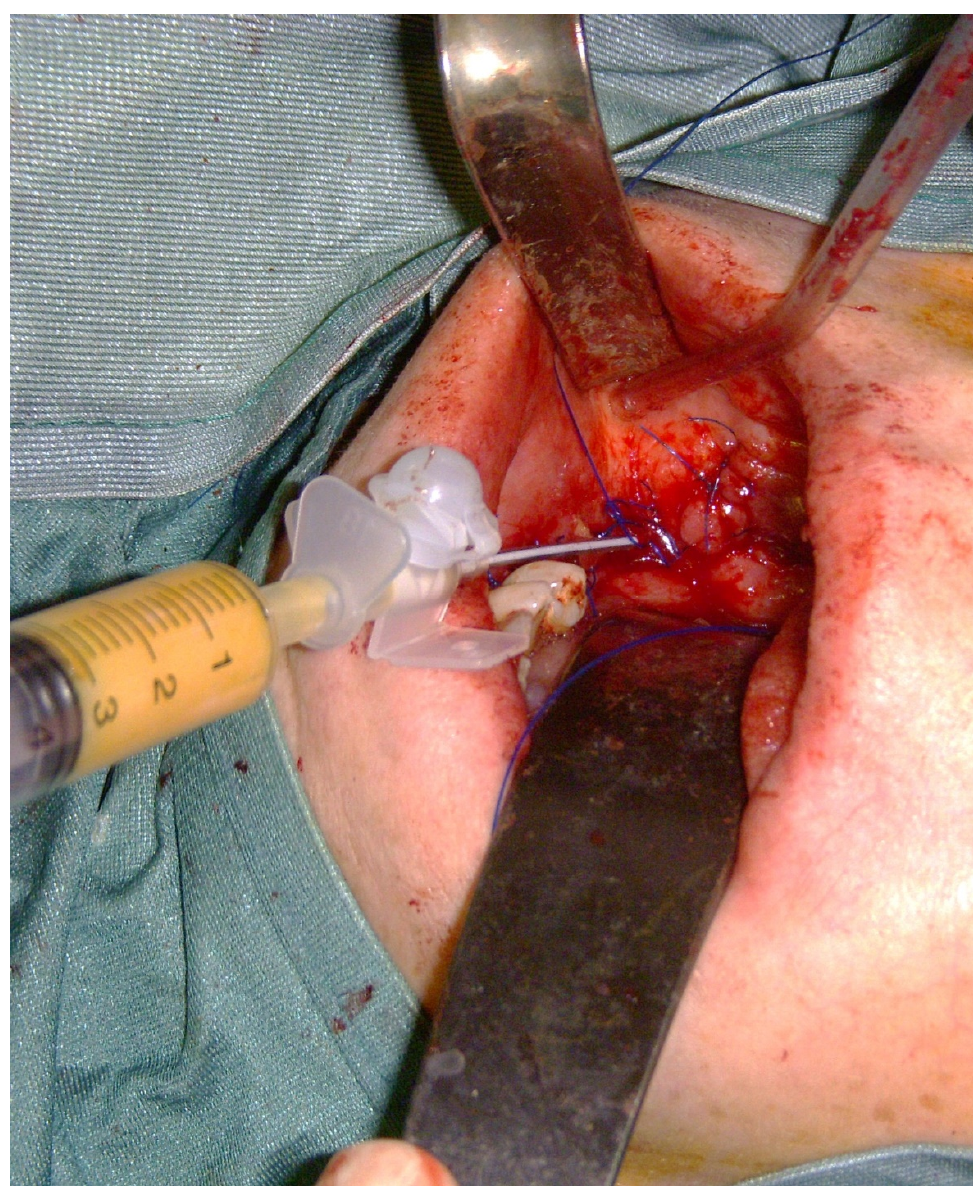
Figure 3. After the fat is transferred to a 5 mL syringe, it is injected through the sutured mucosal margins of the surgical wound until the underlying space is filled.